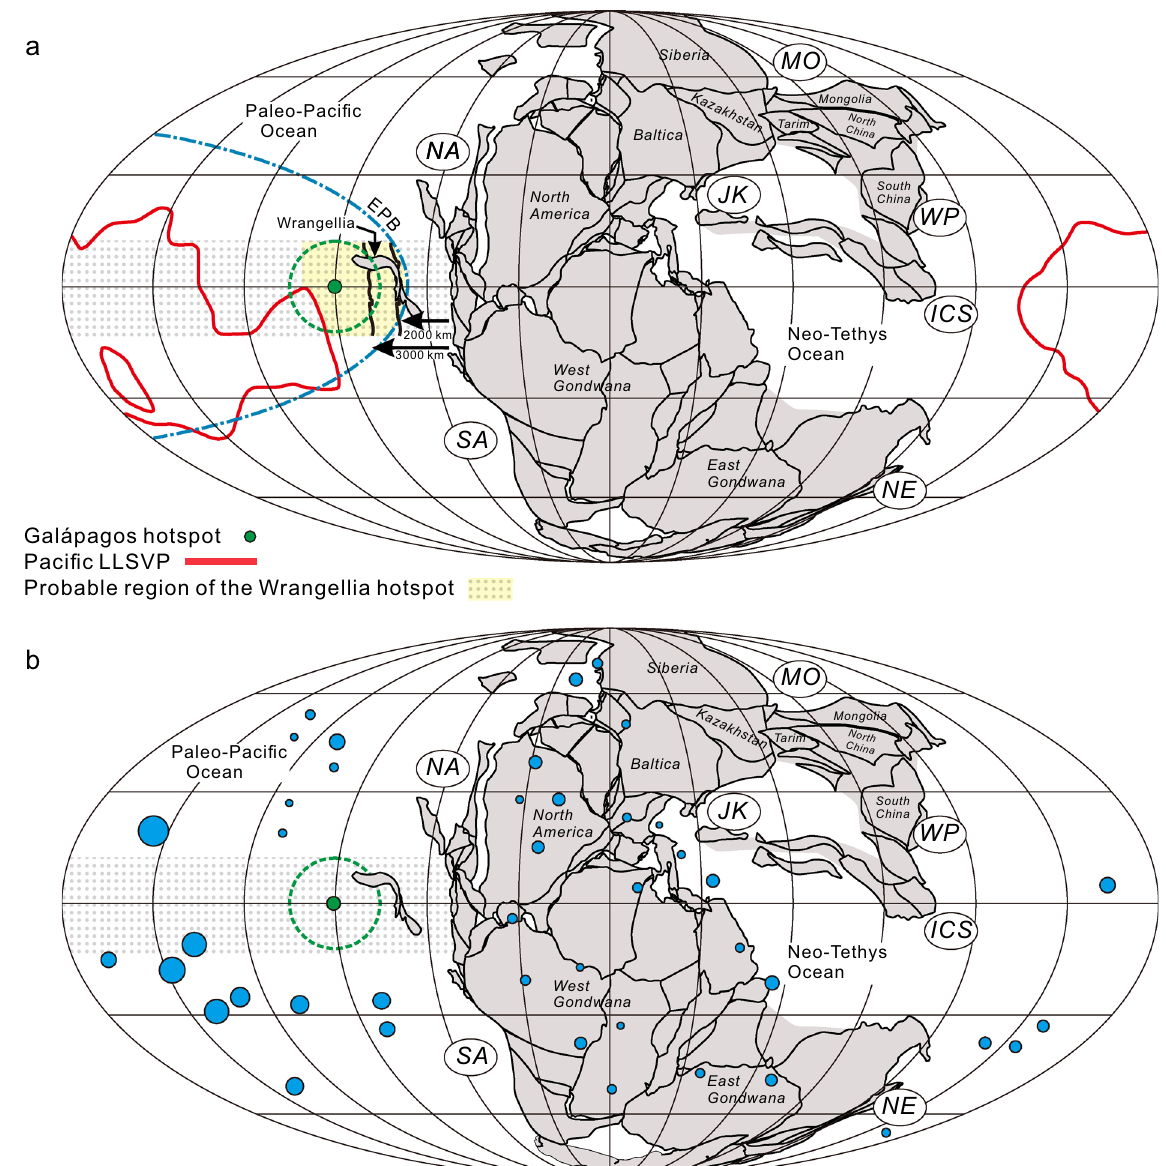
Figure 2. ( a ) Late Triassic paleogeographic reconstruction showing the location of Wrangellia with respect to the permitted paleomagnetic latitudinal range, the Pacific LLVSP 63 , the Eastern Pacific Ocean boundary (EPB) 58 , and the current location of the Galápagos hotspot 52 . The green dashed circle is the permitted plate motion radius of the Galápagos hotspot (± 15°). ( b ) Late Triassic paleogeographic reconstruction showing the locations of the Galápagos hotspot (green circle) and the current (0 Ma) global distribution of active and inactive hotspots (blue) 69 . The size of the hotspot circle corresponds to the magnitude of the anomalous mass flux 69 . NA = North America Cordilleran; SA = South American Cordilleran; NE = New England; ICS = Indochina-Sumatra; JK = Jiangda-Hoh Xil Shan-Karakorum; MO = Mongol-Okhotsk; WP = West